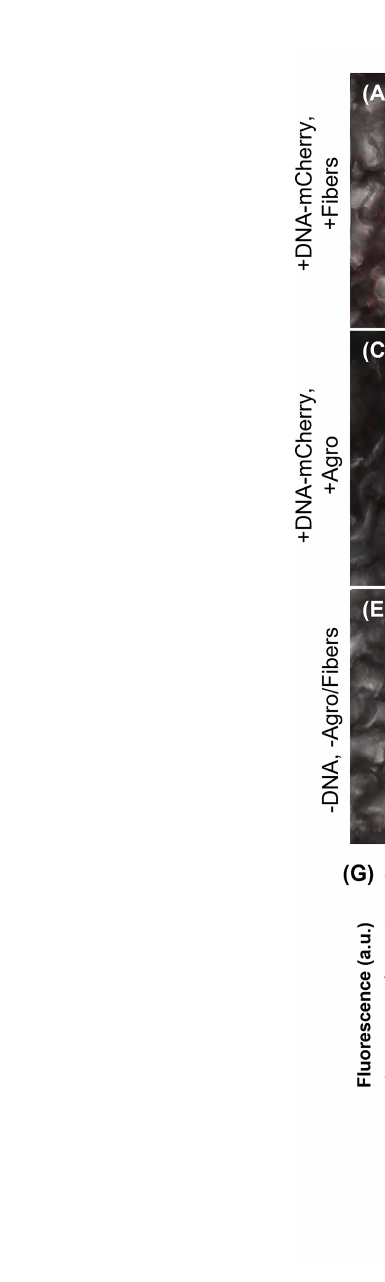
FIGURE 5 Comparison of VACNF- and Agrobacterium -mediated transient transformation. (A) p35S:mCherry/pUC expression 4 d after delivery via VACNFs with 10 µm pitch using the on-plant method in lettuce and (B) 3 d after delivery in N. benthamiana . (C) Agrobacterium -mediated delivery of p35S:mCherry/pCambia in lettuce, 4 d after agroin fi ltration. (D) p35S:mCherry/pCambia 3 d after agroin fi ltration in N. benthamiana . (E) and (F) show background signal for no treatment samples in lettuce and N. benthamiana , respectively. (G) Graph representing average fl uorescence signal intensity of the mCherry fl uorescence of 20×20 m m areas (n ≥ 40, combined results from 2 – 3 experiments). Background signal (no treatment) was subtracted, 2-way ANOVA (and Tukey test) was used for signi fi cance testing, and error bars represent the standard error of the mean. Different letters show signi fi cant differences between treatments ( P < 0.0002). All images are maximum projections of 20 m m z-stacks. Scale bars are 20 m